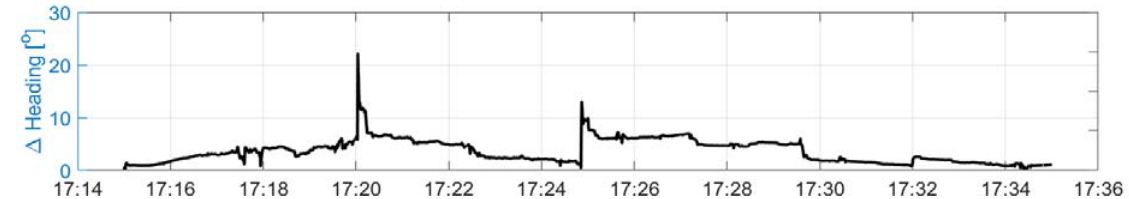
Figure 8. Heading difference between the UWB and GNSS solution from the open-sky